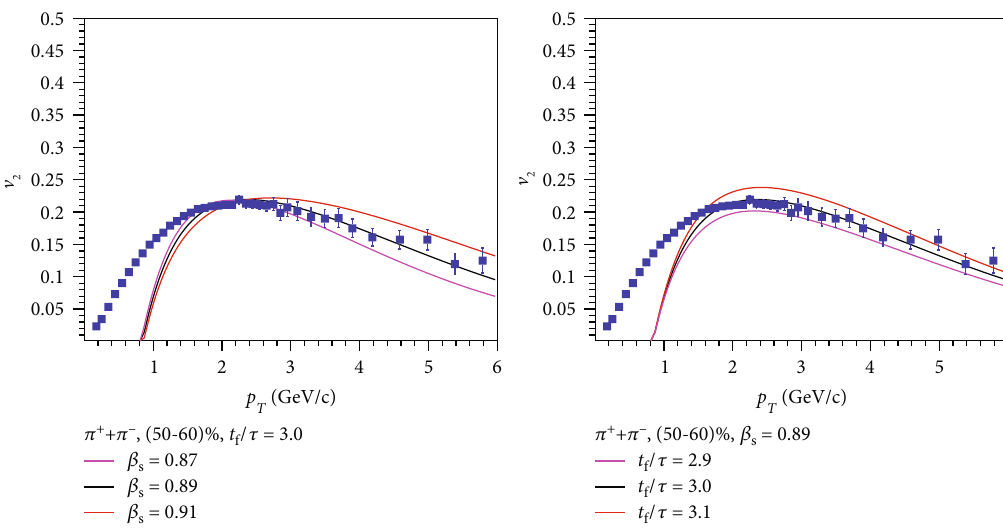
p ffiffiffiffiffiffiffiffi = 2 : 76TeV . Symbols s NN